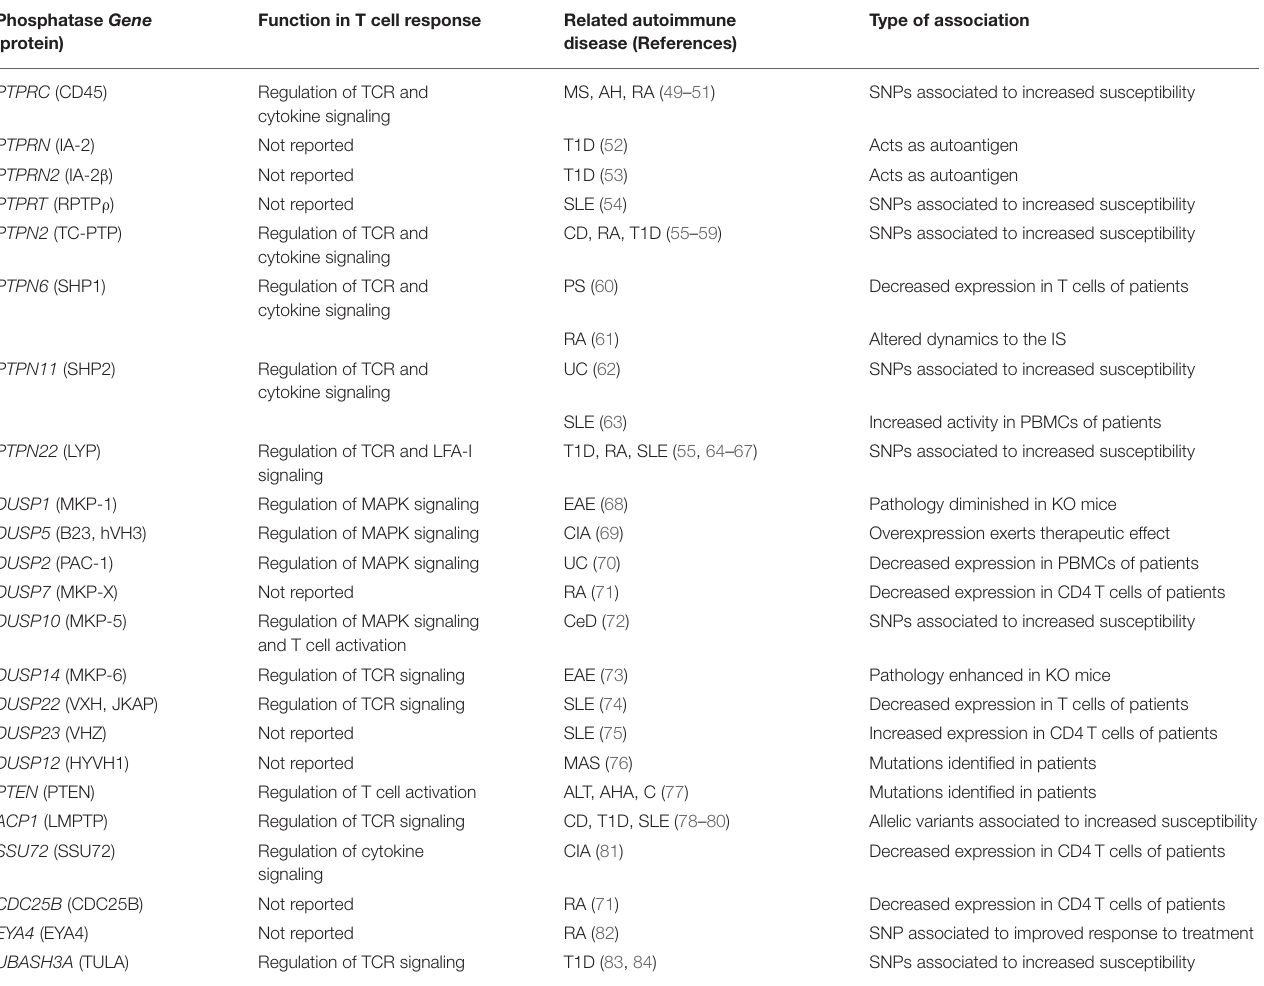
TABLE 1 | PTPs associated to